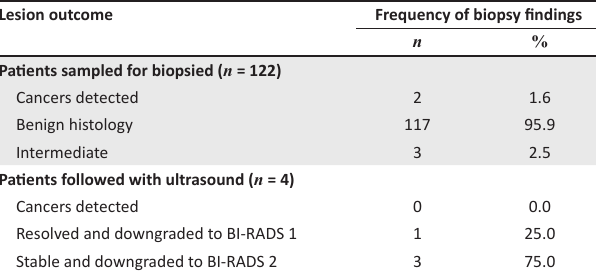
TABLE 2: Outcome of Breast Imaging Reporting and Data Systems 3 lesions.